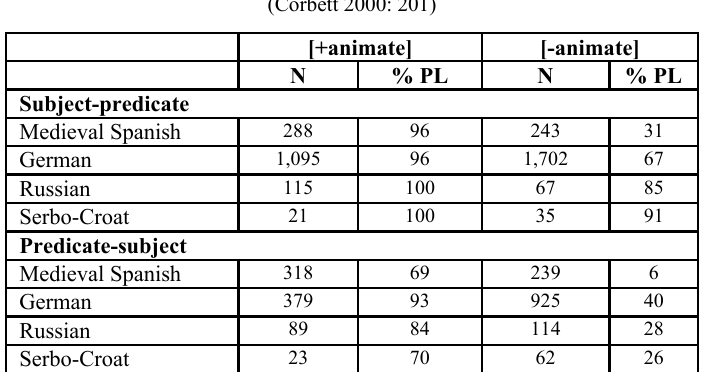
Table XXVII: Agreement with conjoined noun